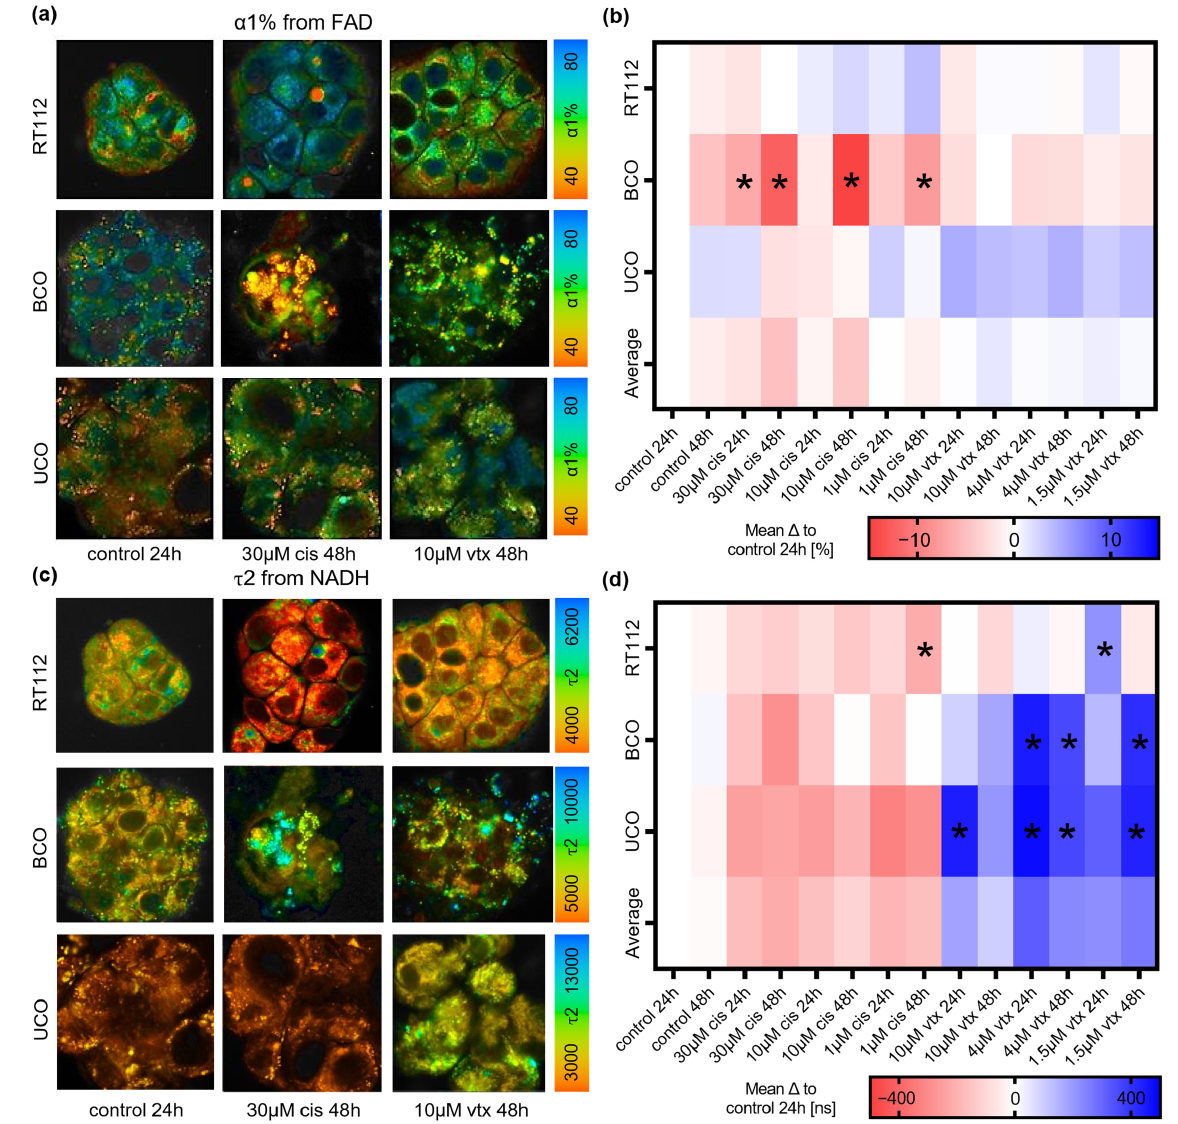
Figure 6. FLIM of bladder cancer organoids. ( a ) Representative FAD α 1% images of control RT112, BCO and UCO organoids and 48 h after 30 µ M cis or 10 µ M vtx treatment. Scale bar: 25 µ m. ( b ) Heatmap of mean differences of NADH α 1% to the 24 h control. ( c ) Representative NADH τ 2 images of control RT112, BCO and UCO organoids and 48 h after 30 µ M cis and 10 µ M vtx treatment. Scale bar: 25 µ m. ( d ) Heatmap of mean differences of NADH τ 2 to the 24 h control. One-way ANOVA, n = 15, * p <